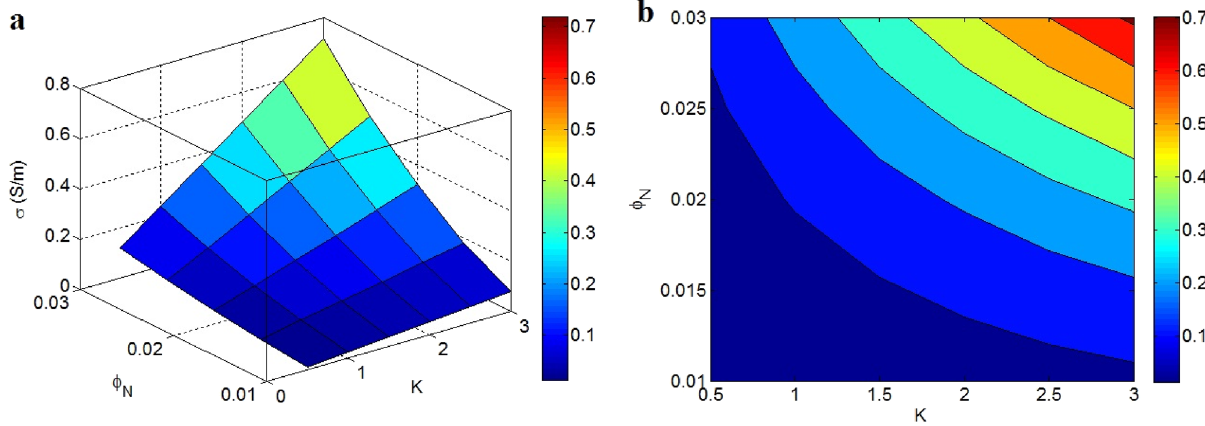
Figure 7. Stimuli of “K” and “ φ N ” on the conductivity: ( a ) 3D and ( b ) contour